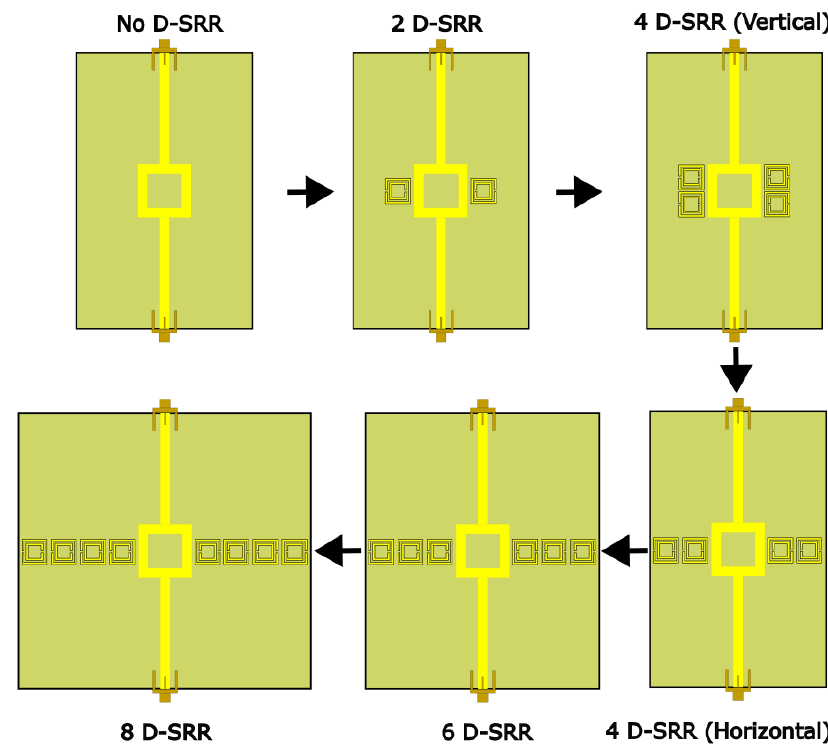
Figure 11. Addition of DSSRs block diagram fl ow process.